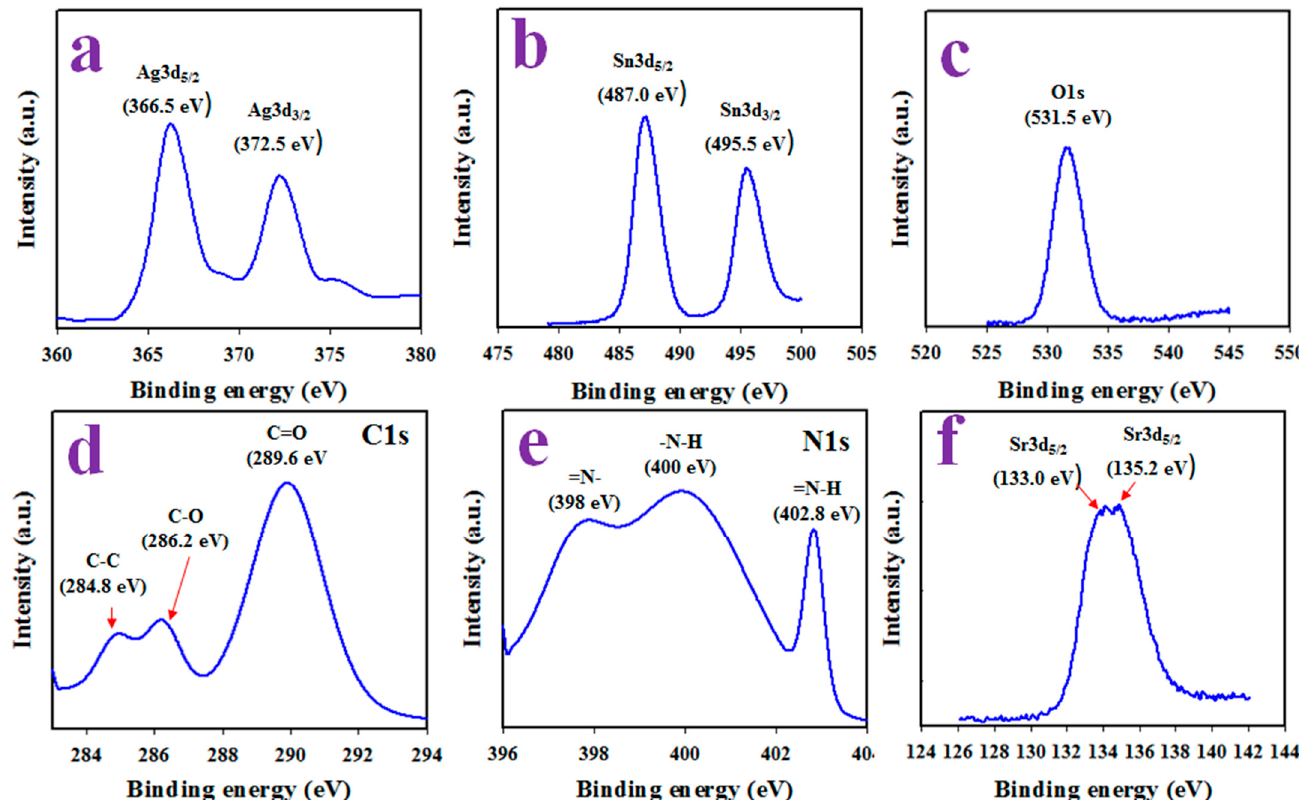
Figure 5. XPS analysis of Ag-decorated Chitosan/SrSnO 3 NC, ( a ) Ag3d, ( b ) Sn3d, ( c ) O1s, ( d ) C1s, ( e ) N1s, and ( f ) Sr3d spectrum. ( e ) N1s, and ( f ) Sr3d